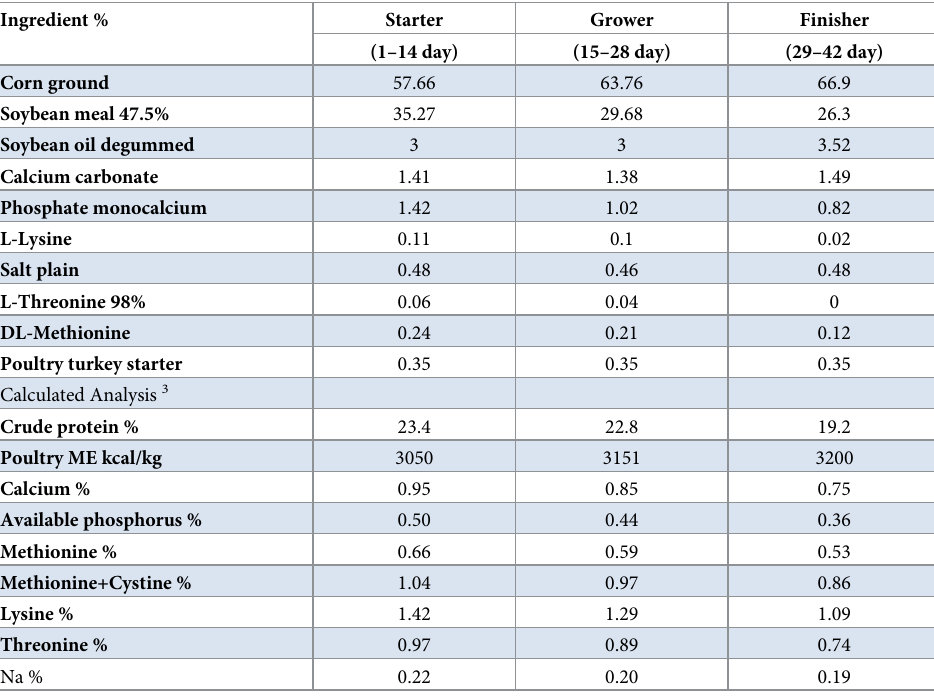
Table 1. Components of base diet 1 , separated by the growth phase 2